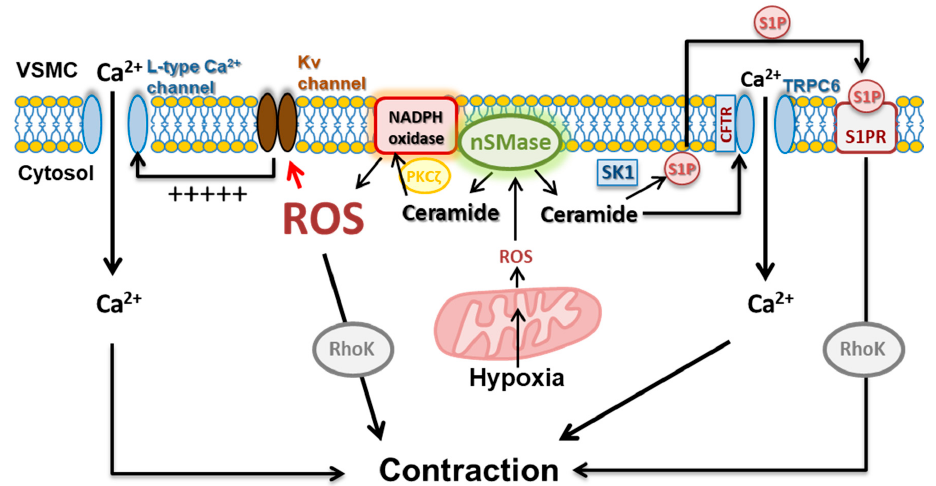
Figure 2. Schematic representation of the role of nSMase-derived ceramide in hypoxic pulmonary vasoconstriction (HPV). Hypoxia promotes mitochondria-derived ROS, which in turn stimulates the production of ceramide from nSMase. Ceramide amplifies ROS production through a PKC ζ -dependent activation of NADPH oxidase. ROS inhibit Kv channels leading to membrane depolarization and activation of L-type Ca 2+ channels, and activate RhoK-mediated Ca 2+ -sensitization. In addition, ceramide via CFTR stimulates Ca 2+ entry through TRPC6 and, via a concomitant activation of SK1, leads to S1P generation which contributes to the contraction though the activation of RhoK. Black lines indicate a stimulatory effect, whereas the red line indicates an inhibitory effect. CFTR: cystic fibrosis transmembrane conductance regulator; Kv: voltage-gated K + channels; nSMase: neutral sphingomyelinase; PKC ζ : protein kinase C ζ ; RhoK: Rho-kinase; ROS: reactive oxygen species; S1P: sphingosine-1-phosophate; S1PR: sphingosine-1-phosophate receptor; SK1: sphingosine kinase 1; VSMC: vascular smooth muscle cell. Black arrows indicate activation and red arrow indicates inhibition.